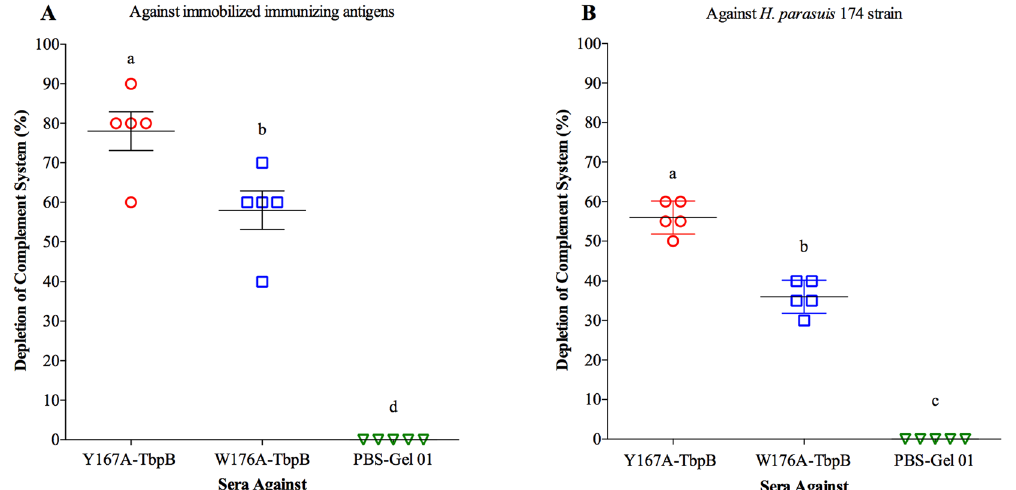
Figure 6. Activation of the classical pathway of the complement system. Heat inactivated sera from pigs immunized with 6 different vaccines were mixed with immobilized immunizing antigens ( A ) or live H. parasuis 174 strain (SV7) ( B ) to deplete complement, and the residual complement measured by erythrocyte lysis. The capacity of these induced antibodies to activate the complement system (deplete complement) is represented as percentage of activation. Different letters indicate significant differences (p < 0.05) between the different